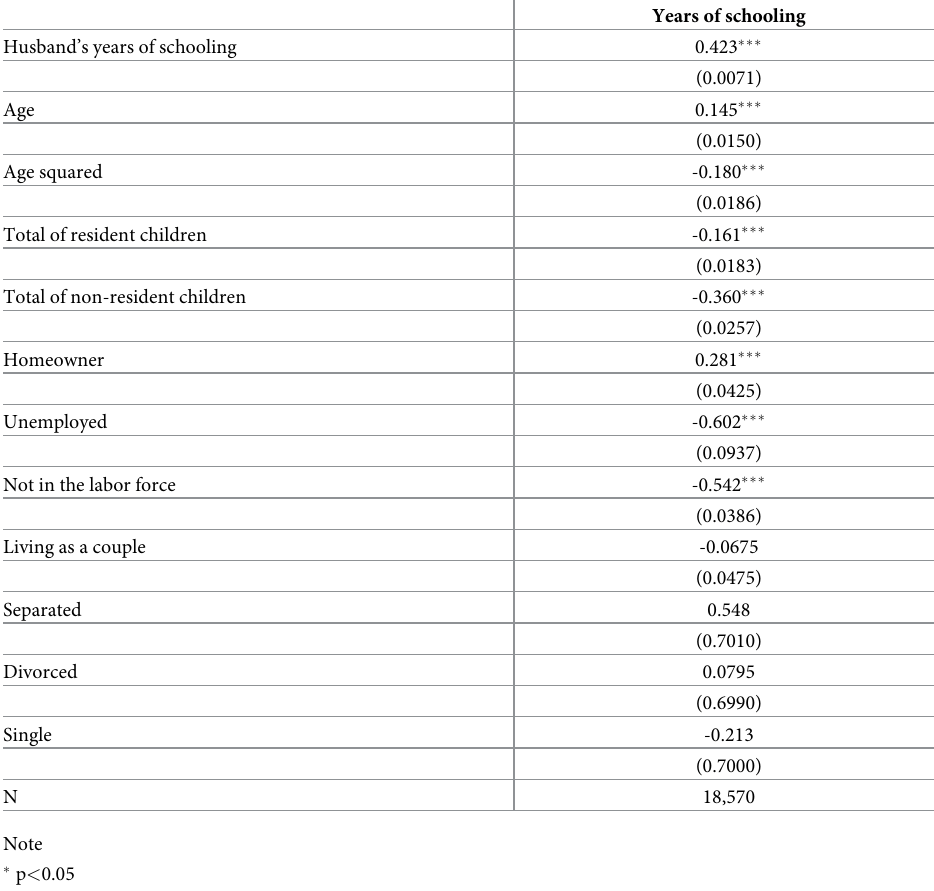
Table 3. First-stage